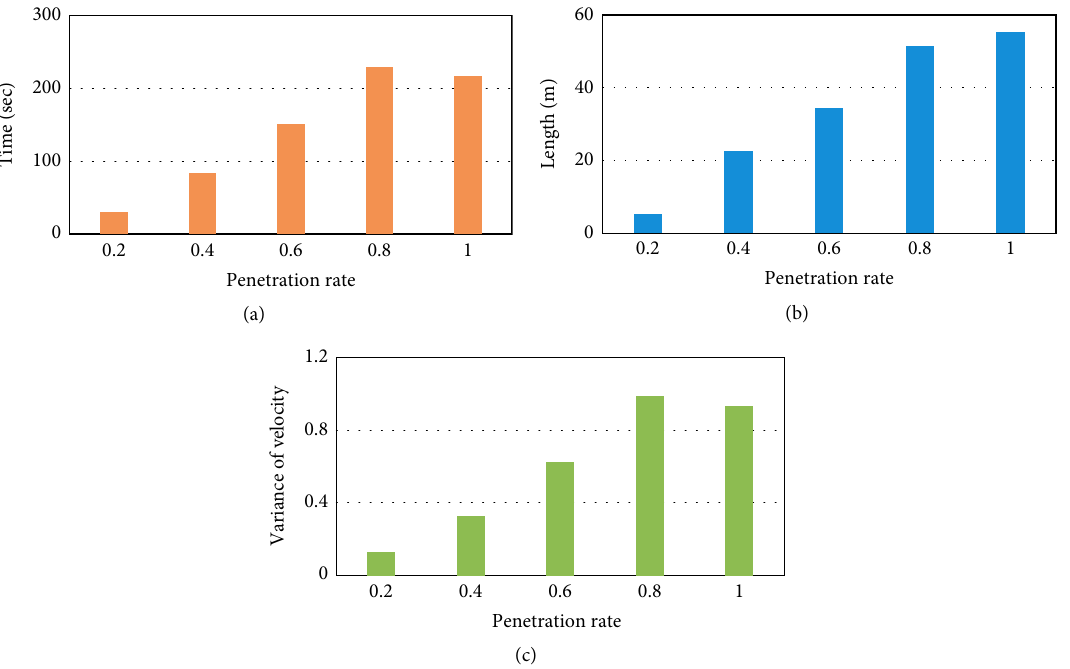
Figure 13: The improvement of three indexes of simulations under each penetration rate of CAV relative to its’ previous penetration rate. (a) Total stopping time of all vehicles. (b) Road length occupied by vehicles. (c) Variance of velocity of all